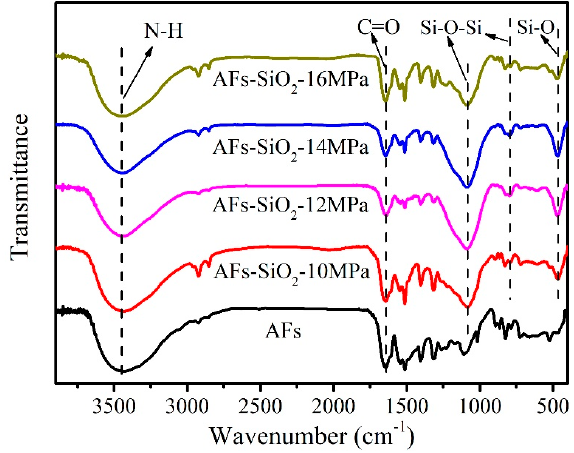
Figure 3. Infrared spectrum of the untreated and nano-SiO 2 -modified fibers.